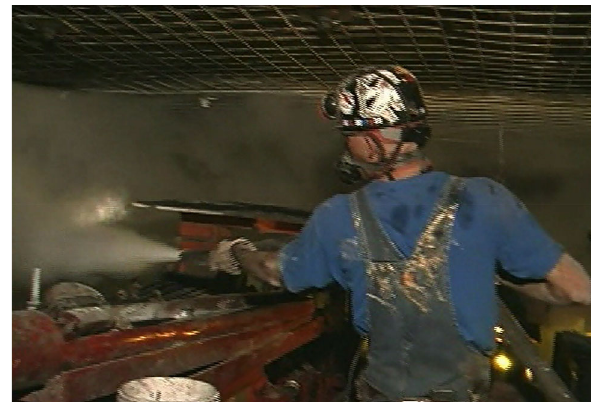
Fig. 6 Manual application of rock dust in a new face area